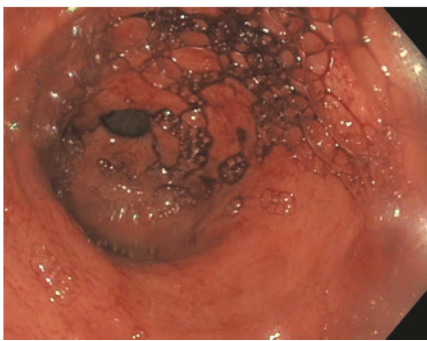
Figure 1: Hemobilia from a ruptured periampullary varix seen dur- ing an endoscopic retrograde cholangiopancreatography (ERCP).